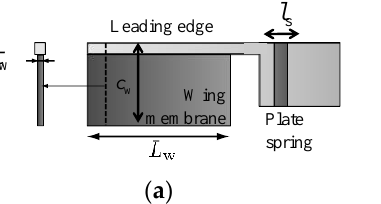
Figure 11. Conceptual view of the 2.5-dimensional wing using the FSI design.